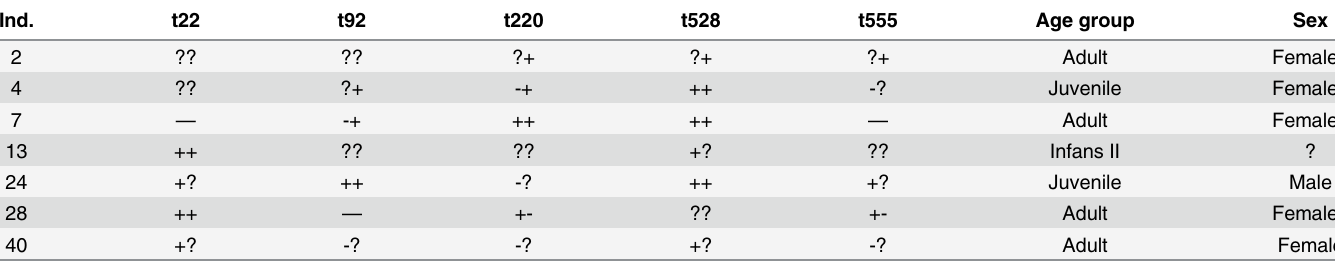
Table 7. Distribution of common traits in Group B. Ind.